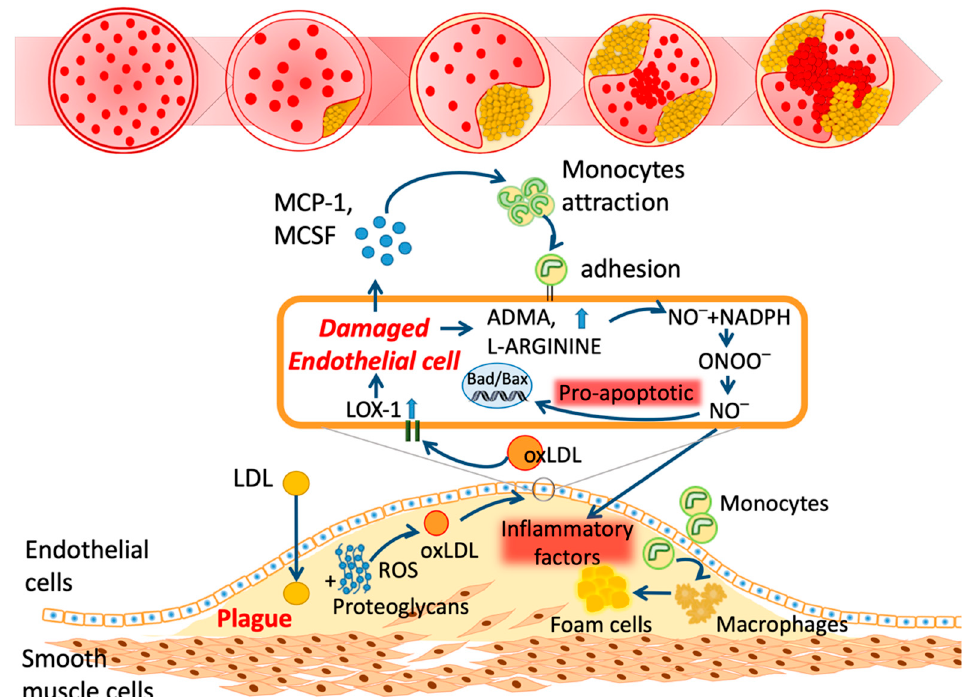
Figure 1. Schematic mechanism of atherosclerosis. LDL: low-density lipoprotein; ROS: reactive oxygen species; oxLDL: oxidized LDL; LOX-1: lectin-like oxidized LDL receptor-1; ADMA: asymmetric dimethylarginine; NO: nitric oxide; NADPH: nicotinamide adenine dinucleotide phosphate; ONOO: peroxynitrite; Bad: BCL2-associated agonist of cell death; Bax: Bcl-2-associated X protein; MCP-1: monocyte chemoattractant protein-1; MCSF: macrophage colony-stimulating factor.